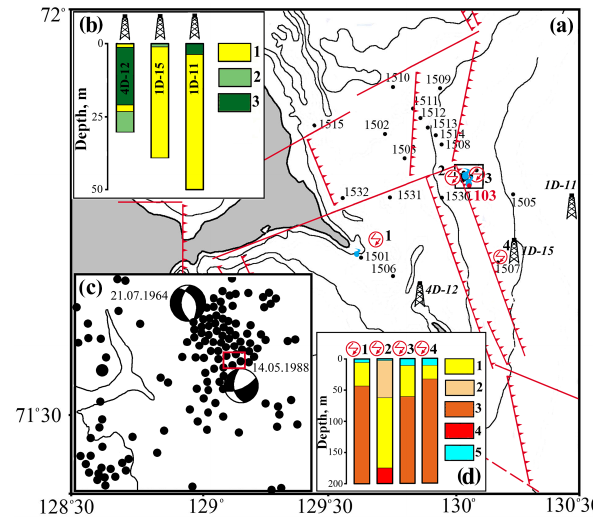
Figure 4. Location of drilling sites and oceanographic stations superimposed on a seismotectonic map modified from Imaev et al. (2004) and overview map of Fig. 2. (a) The red lines with teeth are active faults; the red lines are active faults with kinemat- ics, which have not yet been established; the red dashed lines are the presumed faults; the red rings are the geoelectric survey loca- tions; the blue dots with a tail are the locations where SGD was discovered; the black tower are the locations of drilling operations. (b) Grain size composition of the drilling cores 1D-11, 1D-15, 4D- 12. (1) Sand, (2) predominantly silt, (3) predominantly clay. (c) The map of the earthquake epicenters and focal mechanisms. The small dots are earthquakes with a magnitude ≤ six. The large circles are earthquakes with a magnitude > six, placed near the date of their occurrence. (d) Resistivity in the bottom sediments ( (cid:127) m): (1) 0– 5, (2) 5–10, (3) 35–100, (4) > 350, (5) water. A table with more detailed information can be found in Supplement Table